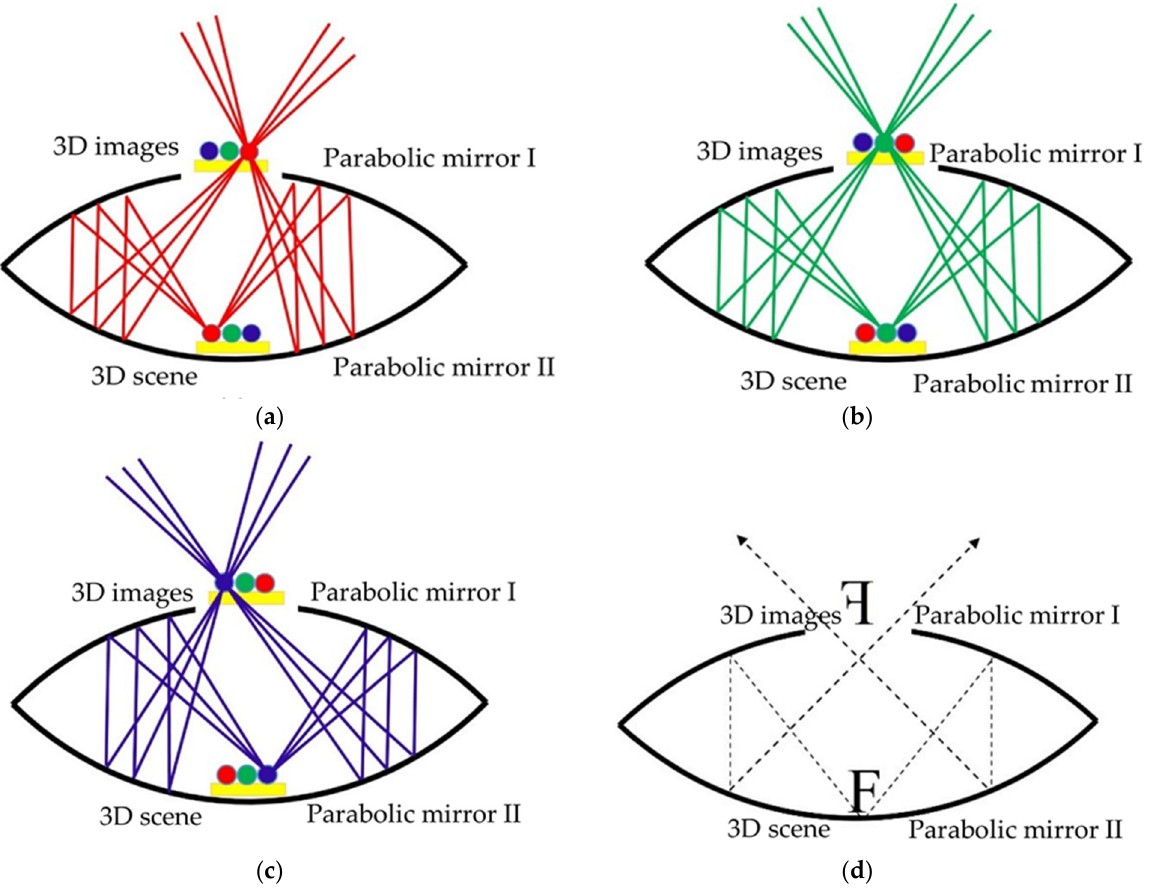
Figure 5. The imaging principle of the parabolic mirrors: ( a ) the red ball reconstructed in the right side of parabolic mirror II; ( b ) the green ball reconstructed in the center of parabolic mirror II; ( c ) the blue ball reconstructed in the right side of parabolic mirror II; ( d ) the reconstructed image inverted in the left and right spaces.